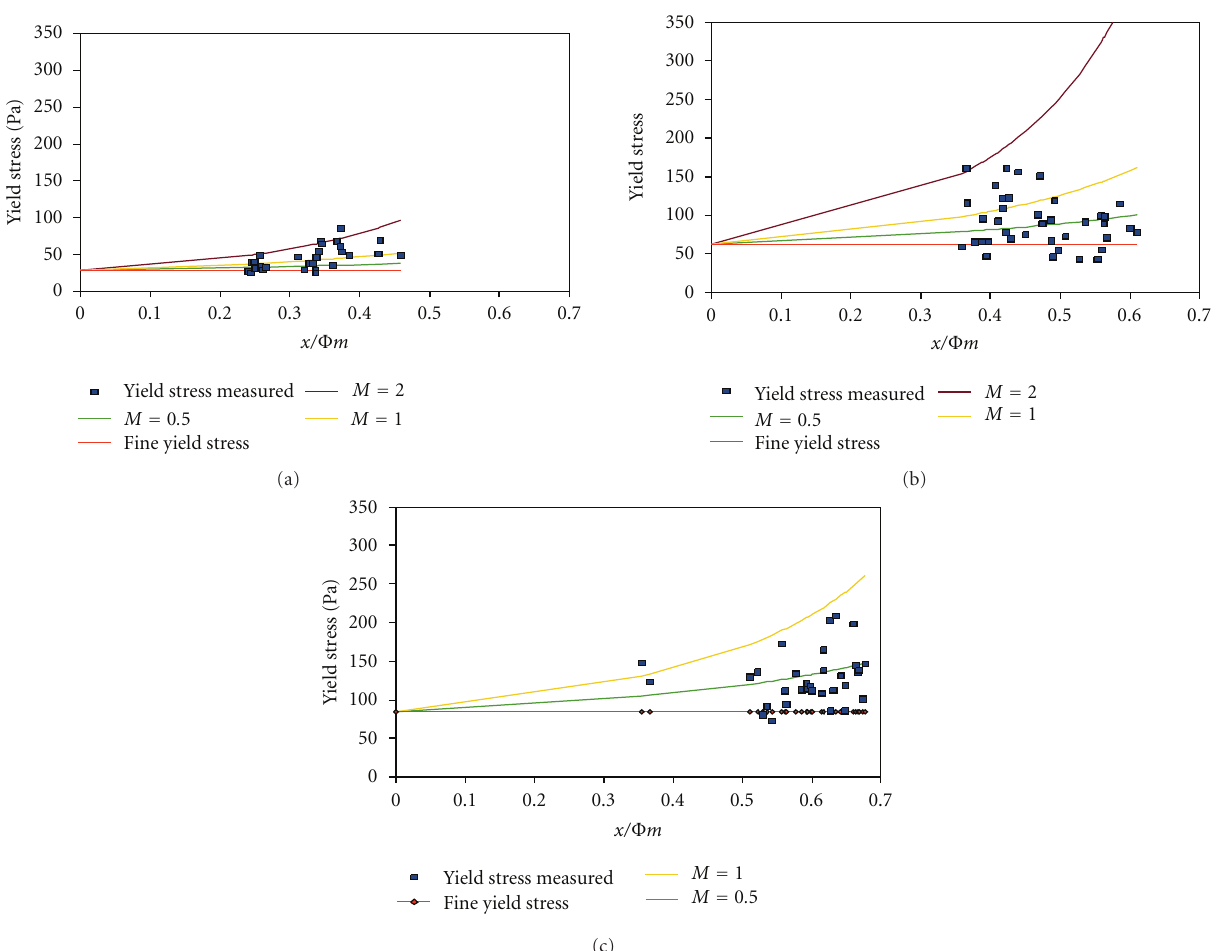
Sediment is a complex mixture, with di ff erent phases, more or less saturated, exhibiting a large scattering of the rheological